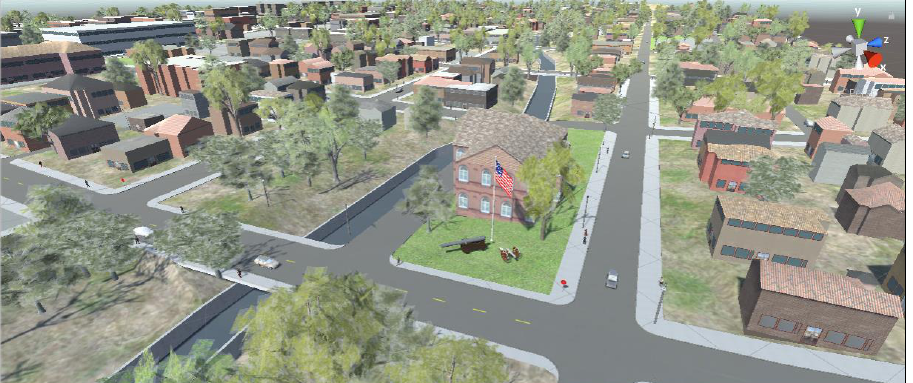
Figure 8. CityEngine model displaying the concrete channel reach of the Portneuf River and the Bannock County Veteran Memorial building. Bannock County Veteran Memorial